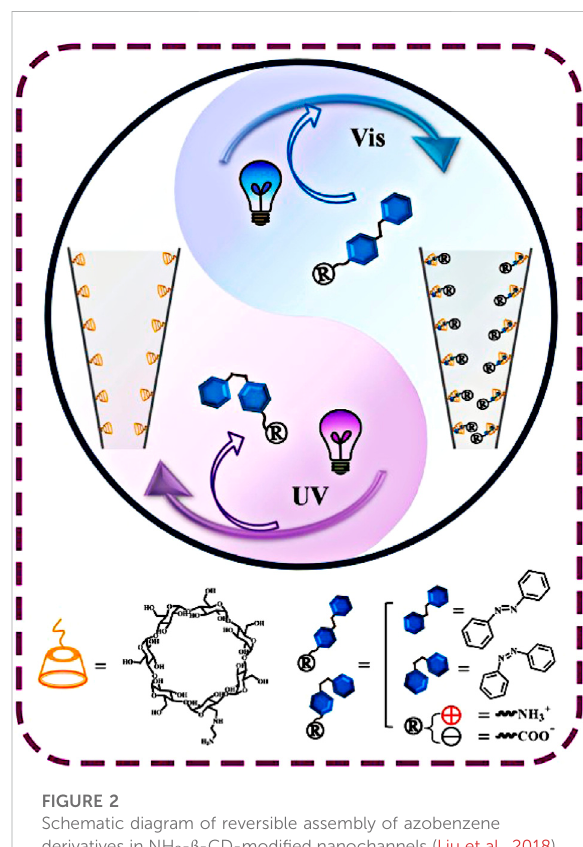
FIGURE 2 Schematic diagram of reversible assembly of